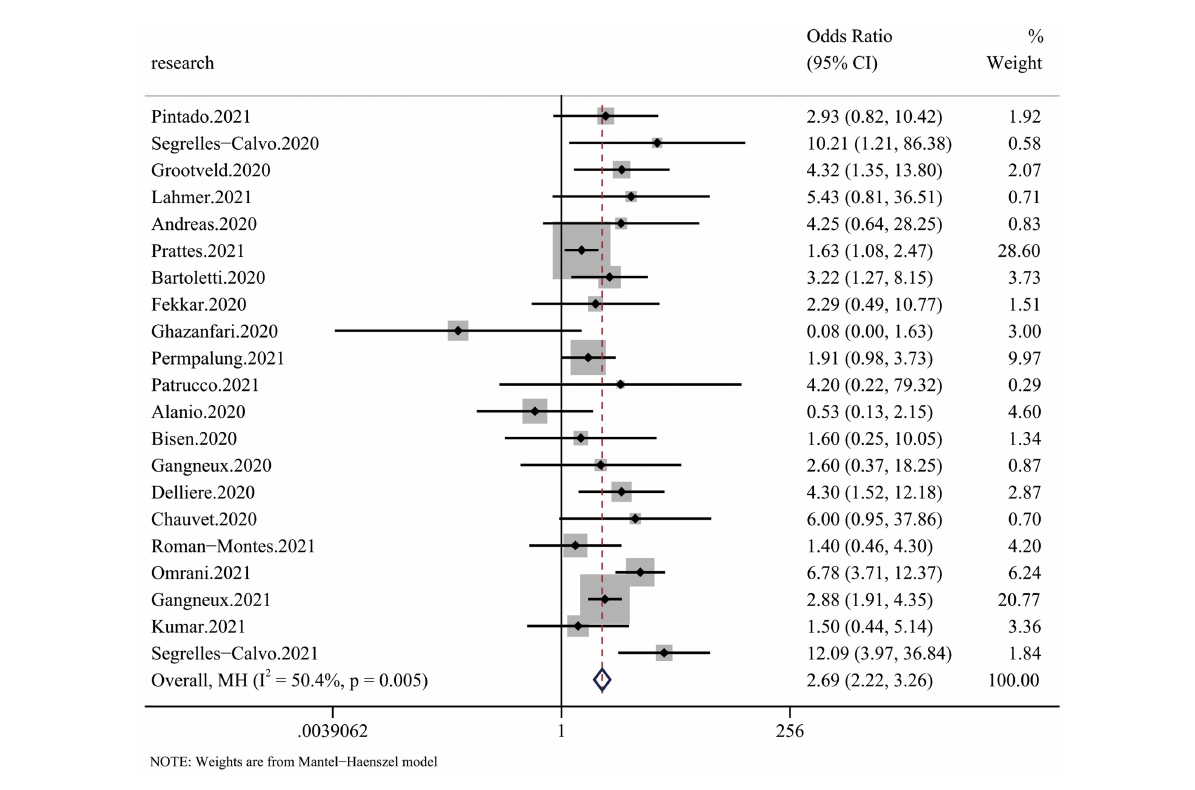
FIGURE2 Forest plot of pooled mortality showing the ORs of the included articles ( n = 20). The pooled OR for COVID-19 associated with mycotic infection (CMI) was 2.69 (95% CI: 2.26–3.33).